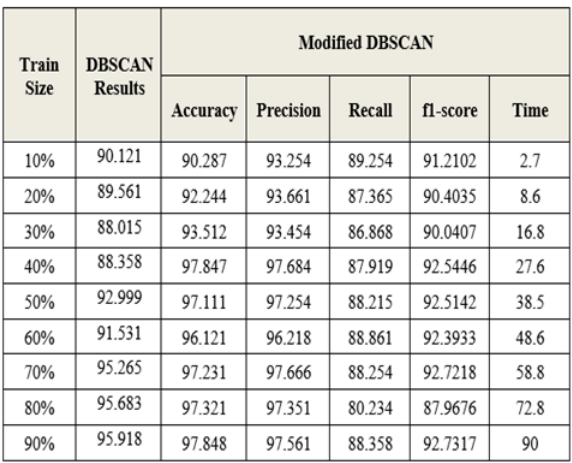
Table 1. The evaluation Results of the Modified- DBSCAN with N-representative